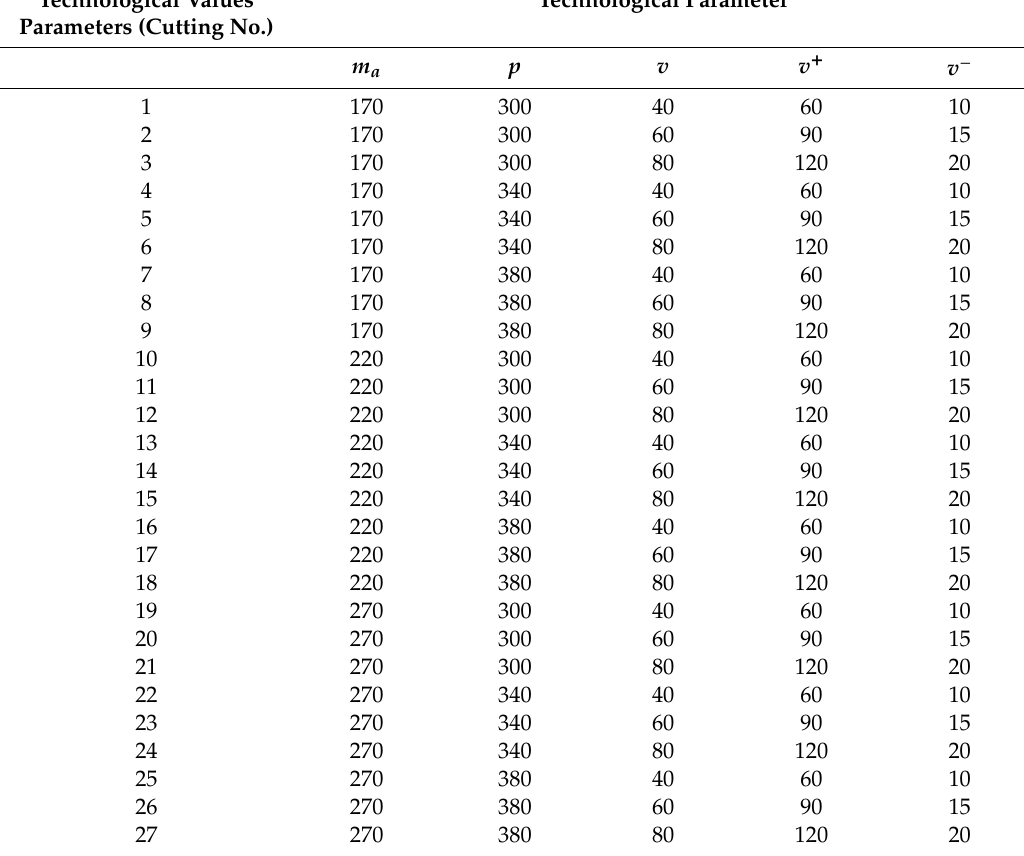
Table 2. Combinations of technological parameter values for sets of experiments. Combination